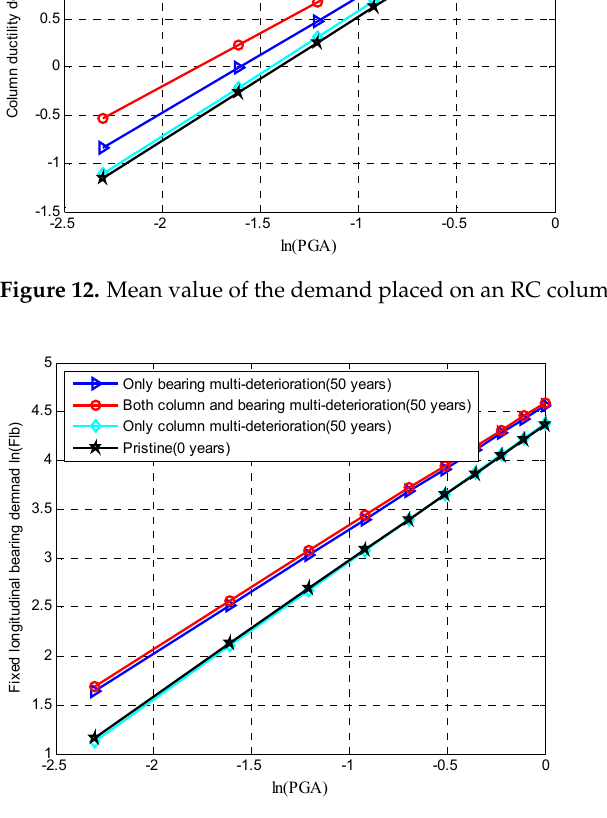
Figure 12. Mean value of the demand placed on an RC column through PSDM.